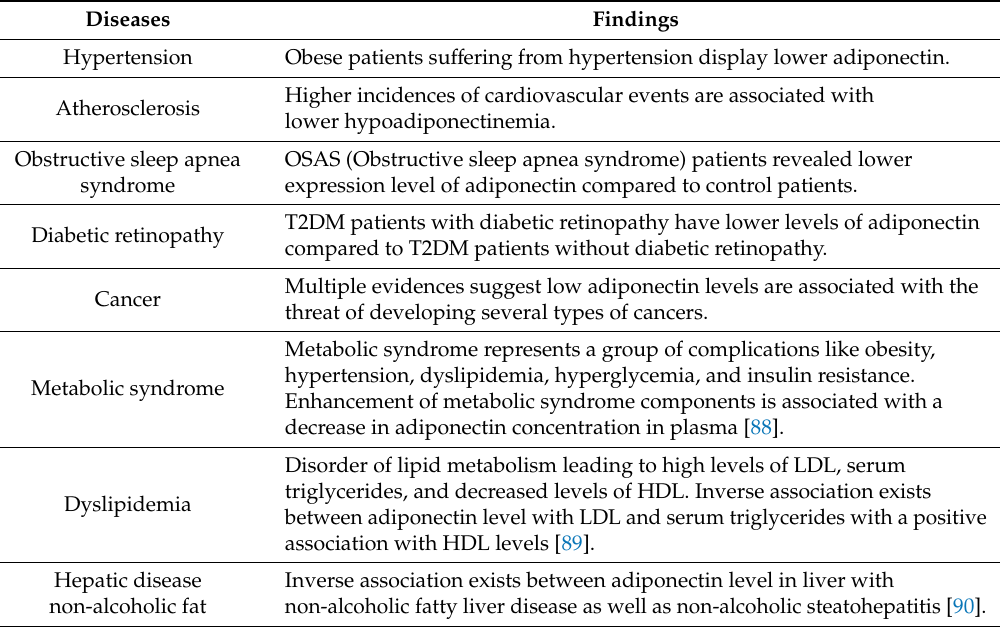
Table 1. Obesity-related diseases associated with